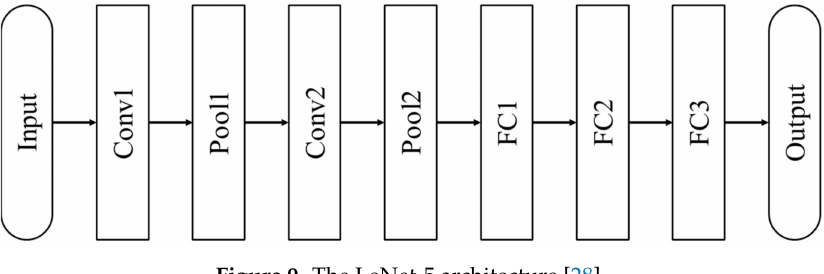
Figure 9. The LeNet-5 architecture [28].